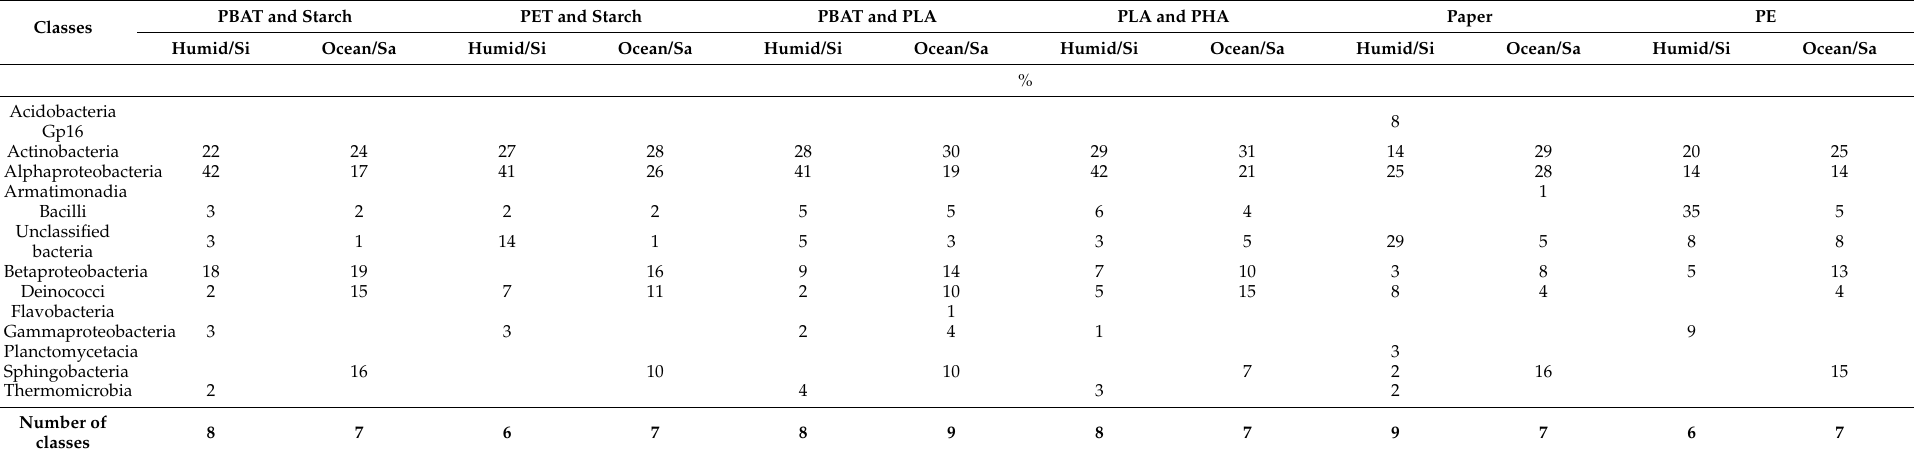
Table 3. Populations of bacteria, expressed as percentages and divided by classes, found on different mulches and in two locations. Humid/Si: location with humid subtropical climate (Cfa, according to the Köppen classification) and silt loam soil. Ocean/Sa: location with temperate oceanic climate (Cfb, according to the